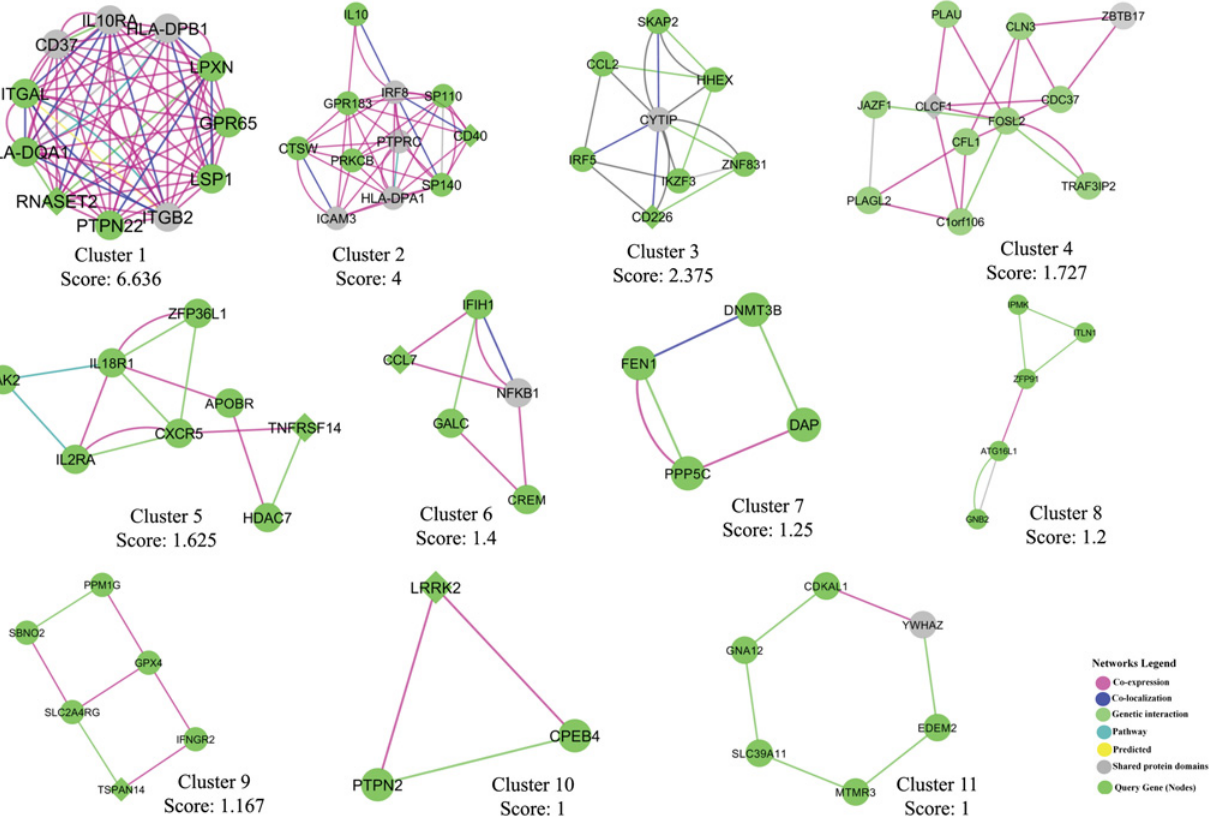
Fig 7. Top MCODE clusters from the gene interaction network. Highly connected gene clusters were identified from the network using MCODE v1.32 (a Cytoscape 2.8.2 plugin) and the top 11 clusters are presented (cutoff score (cid:1)